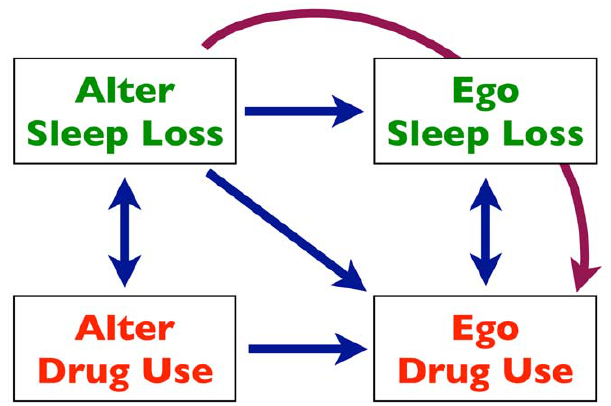
Figure 4. Summary of results. Blue arrows indicate significant direct relationships, while the purple arrow indicates the only mediation relationship that was found to be significant between alter sleep behavior and ego drug use. Arrows from alter to ego are directional because the statistical evidence suggests that at least some of the associations result from a causal